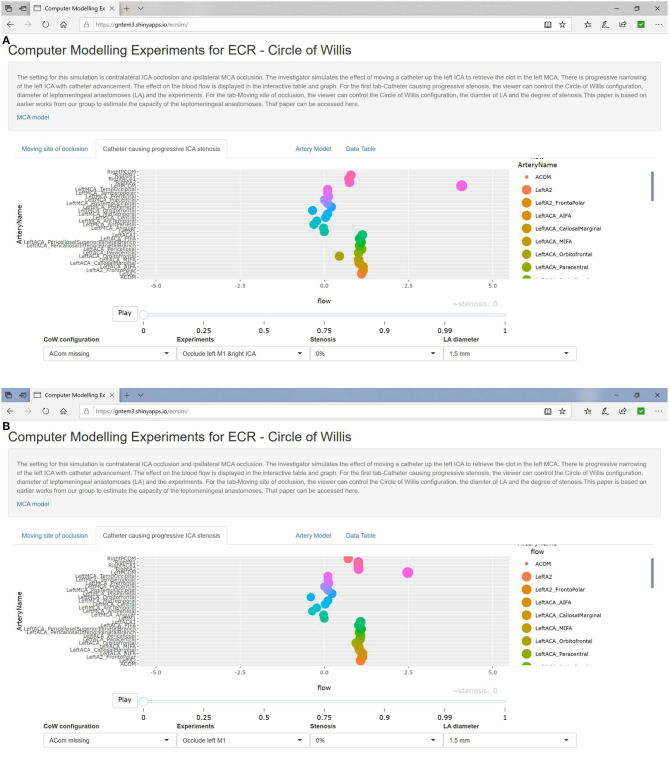
(A) Left MCA occlusion and contralateral ICA occlusion. (B) Left MCA occlusion only. Catheter movement has no effect even at 100% stenosis (absence of contralateral ICA occlusion).